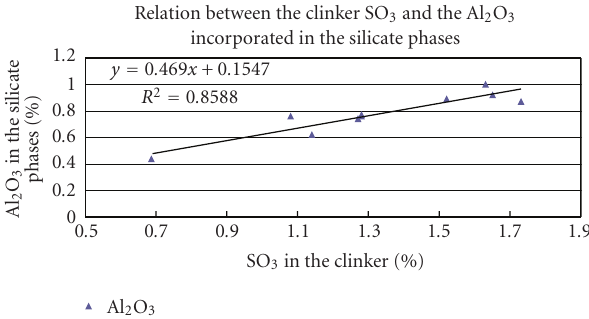
Figure 2: Relation between the total clinker SO 3 and the alumina incorporated in the silicate phases forced by